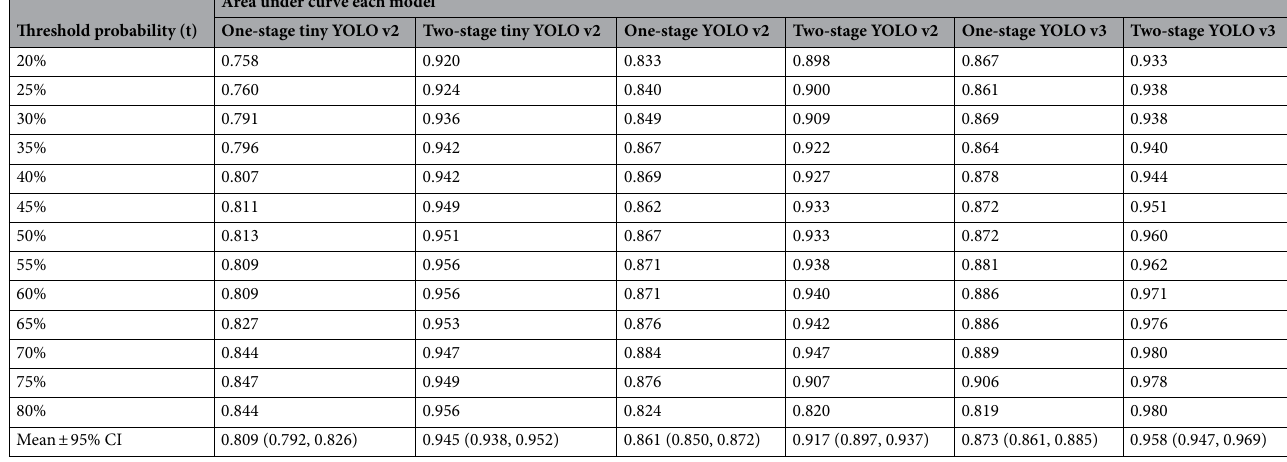
Table 3. Determination of AUC by threshold probability ( t ).